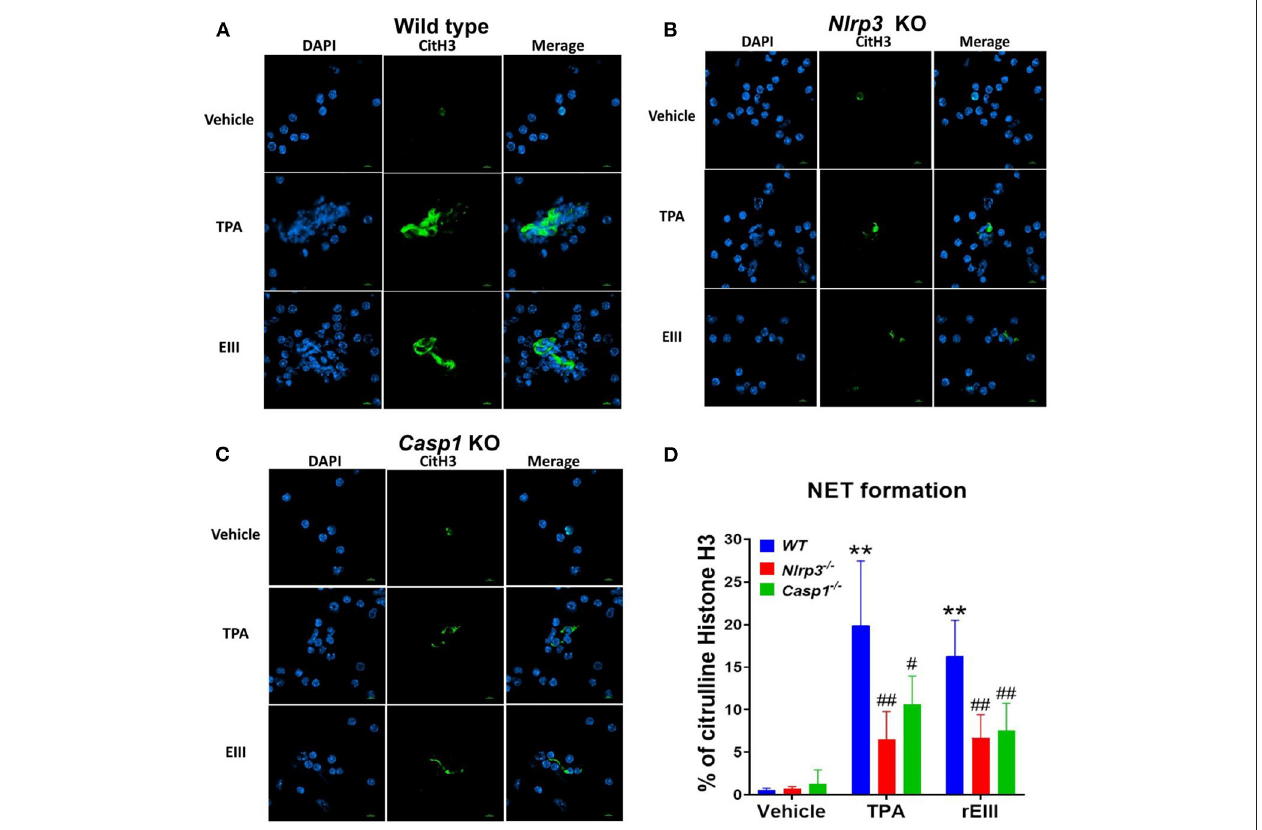
FIGURE 2 | Essential role of Nlrp3 inflammasome in DENV rEIII-induced NETosis. After challenged (1h) by TPA (2nM) and DENV rEIII (0.6 µ M), the images of DAPI (nucleus DNA staining) and citrullinated histone H3 (CitH3; NETosis marker) staining of NETosis formation of neutrophils from wild type (A) , Nlrp3 null ( Nlrp3 − / − ) (B) , and caspase 1 null ( Casp1 − / − ) (C) mouse were showed. The quantified results from flow cytometry are also indicted (D) . n = 6, ** P < 0.01, vs. vehicle controls; # P < 0.05, ## P < 0.01 vs. wild type (WT) groups. Scale bars: 5 µ m.